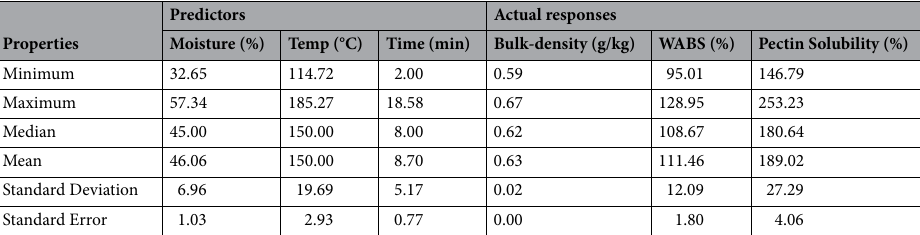
Table 1. Descriptive Property of Raw Data. The summary in Table 1. is for the 45 numbers of experiments